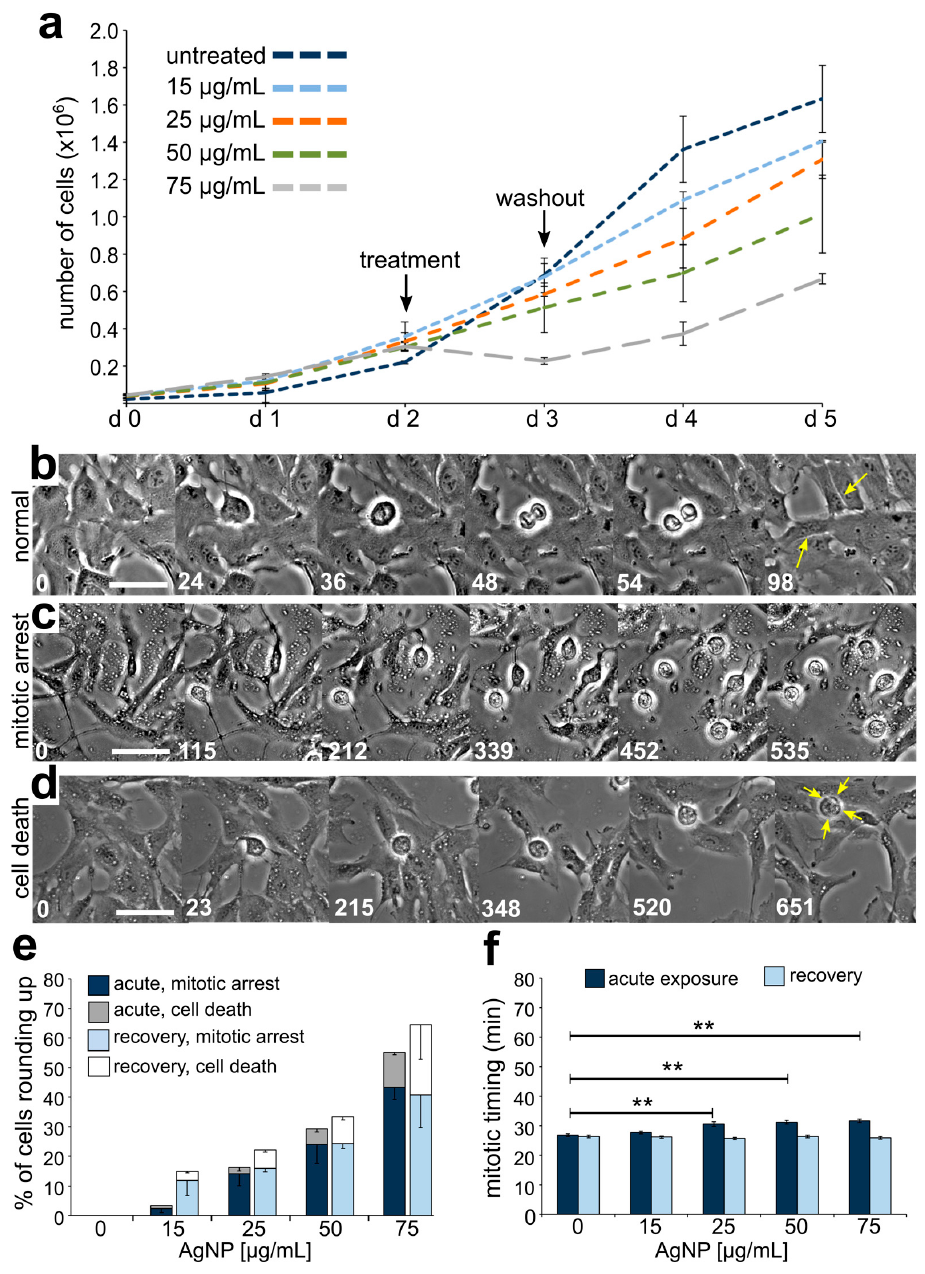
Figure 4. E ff ects on cell division and cell proliferation from acute AgNP exposure and recovery. ( a ) Growth curves for cells treated with increasing concentrations of AgNPs. ( b – d ) Still frame images from time-lapse microscopy showing: ( b ) a cell undergoing normal mitosis (yellow arrows pointing at the two resulting daughter cells), ( c ) cells rounding up and remaining rounded for more than 3 h (considered arrested), and ( d ) a cell rounding up and subsequently displaying signs of cell death (yellow arrows). Numbers indicate the elapsed time in min; Scale bars, 10 µ m. ( e ) Percent of cells observed to either arrest or die after rounding up. The data corresponding to events observed during treatment are shown in darker colors (dark blue and grey) whereas the data corresponding to events observed during recovery are shown in lighter colors (light blue and white). ( f ) Mitotic timing in cells completing mitosis during an acute AgNP treatment (dark blue bars) or recovering from an acute AgNP treatment (light blue bars). ** t-test, p <